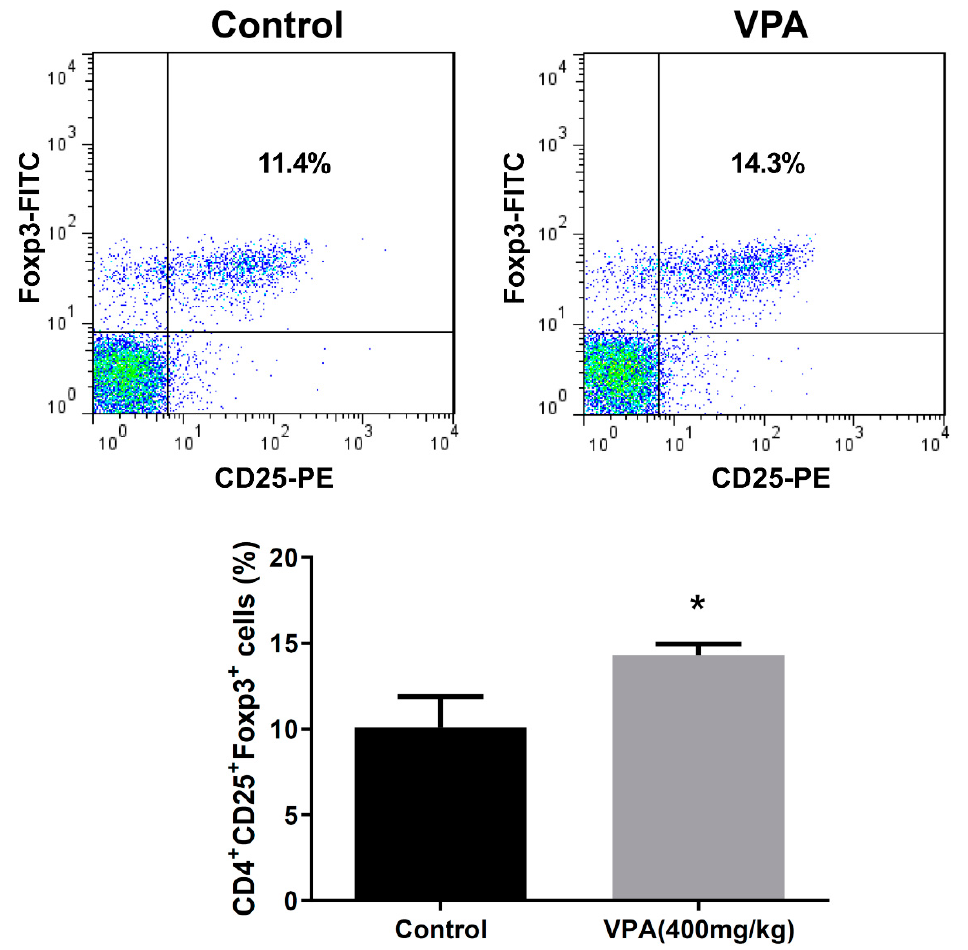
Figure 6. The effect of VPA treatment in the population of Treg cells in the spleen of NOD mouse after islet transplantation. The population of Treg cell in the splenocyte of PBS-treated or VPA-treated NOD recipients was analyzed by flow cytometry. The percentage of Treg cells was significant higher in VPA-treated group than PBS-treated control. Data are expressed as the mean ± SEM (* = p < 0.05; n = 4).